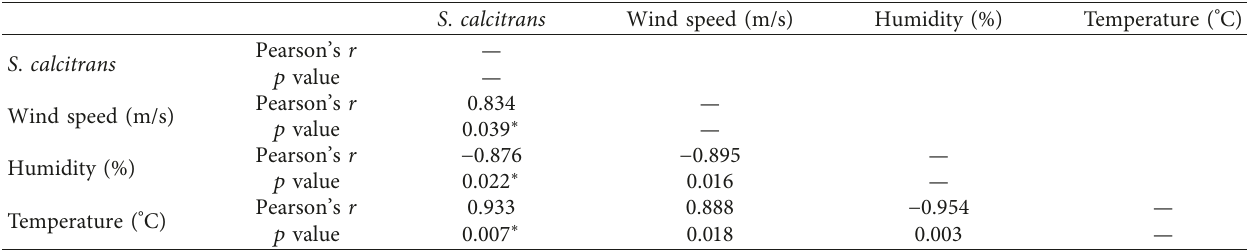
Table 5: Correlation matrix of daily ADT of S . calcitrans with weather variables.